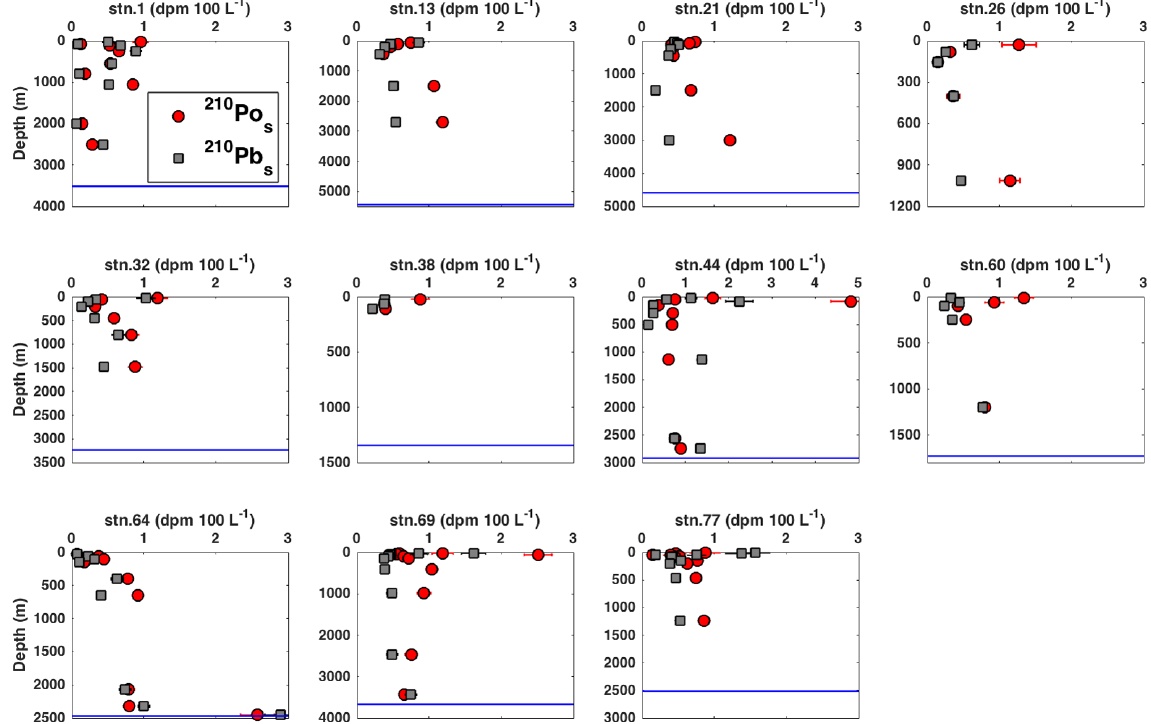
Figure 4. Vertical profiles of the particulate 210 Po and 210 Pb activity in the small size fraction (1–53µm, 210 Po s , 210 Pb s ) . Note that the depth scale may differ among plots, and the activity scale at station 44 differs from the scale in all other plots. The horizontal blue line represents the bottom depth at that